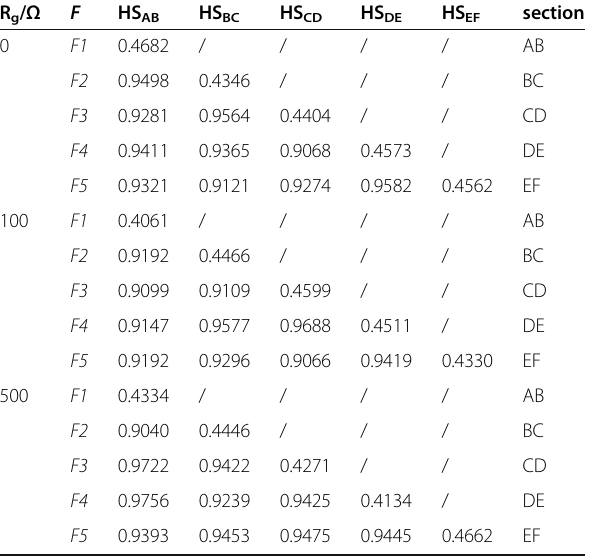
Table 7 Results of the proposed positioning method ( φ = 30 ∘ , arc suppression coil grounding system)